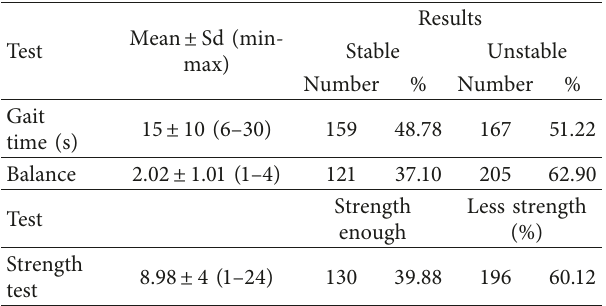
Table 3: Gait, balance, and strength test results among study subjects.